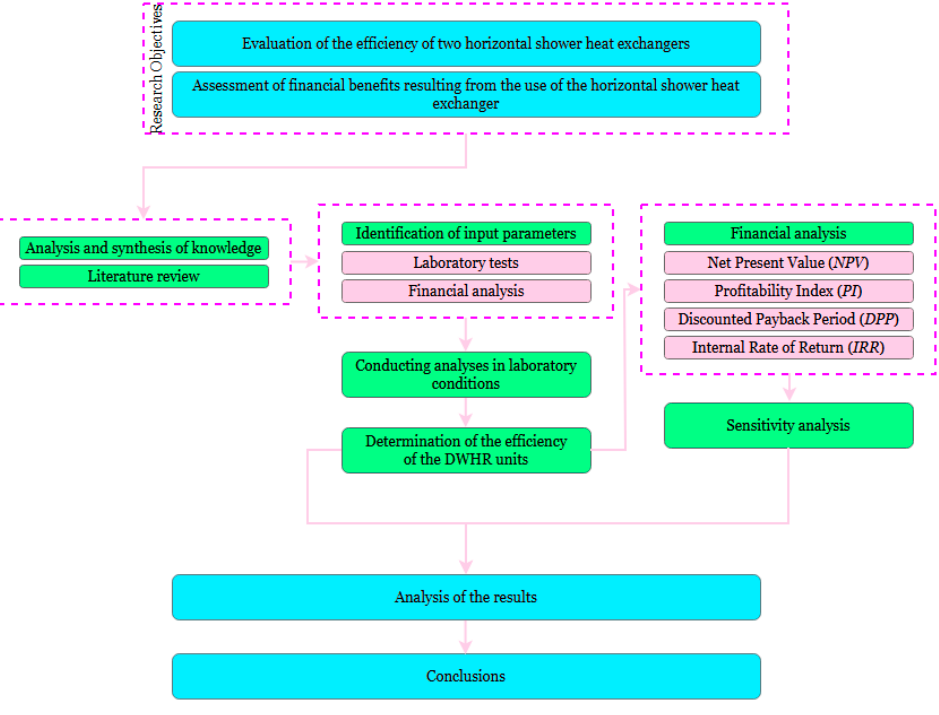
Figure 3. Research plan.